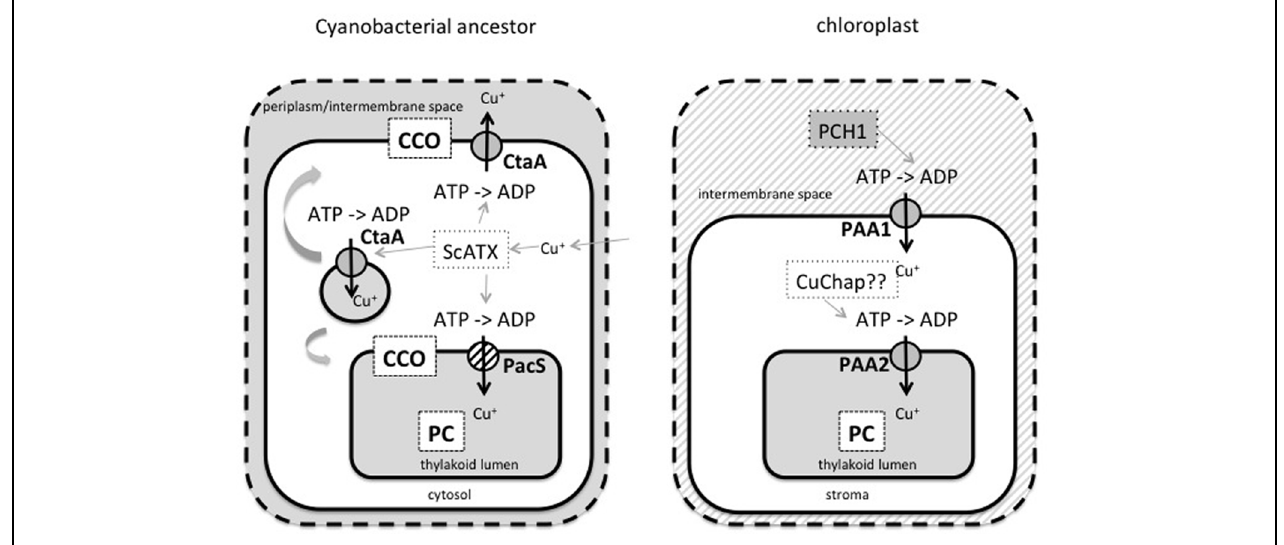
FIGURE 3 | Model for the evolution of chloroplast Cu transport from a hypothetical cyanobacterial ancestor of the chloroplast. Cyanobacteria, such as Synechocystis , contain two major Cu proteins, PC in the thylakoids and CCO in both the thylakoids and inner membrane of the envelope. In these cyanobacteria two Cu-transporting P-type ATPases called CtaA and PacS are present together with a copper chaperone ScATX that can interact with both transporters. ScATX serves to sequester Cu ions that entered the cytosol by low affinity pathways and to deliver the Cu ions to CtaA and PacS. PacS is in the thylakoid membranes and loss of function affects both Cu tolerance and PC maturation. CtaA is presumably present in the inner membrane and maybe in addition in an internal vesicle. We propose that CtaA has the indicated topology, which allows the protein to deliver Cu to the exoplasmic side of membranes to allow maturation of both the CCO complex and PC. If CtaA is active in an internal vesicle then Cu ions can reach CCO and PC via a vesicular transport mechanism involving membrane fusion. After endosymbiosis gave rise to the chloroplast, both PacS and ScATX were lost. Nucleus encoded PAA1 and PAA2 then evolved from CtaA with the addition of a transit peptide for chloroplast targeting and for PAA1 also a poly-glycine stretch to ensure envelope retention and correct (novel) topology. In addition, alternative splicing or gene duplication allowed the evolution of the novel Cu chaperone PCH1 from PAA1/CtaA. In analogy to the use of the N-terminus of PAA1 as a copper chaperone, PAA2 may use its N-terminal region as a Cu chaperone in the stroma (CuChap, hypothetical at present) that might be derived from the full transporter via proteolytic processing. Alternatively PAA2 may receive Cu ions that bound to low molecular weight chelators in the stroma or from CCS protein (not